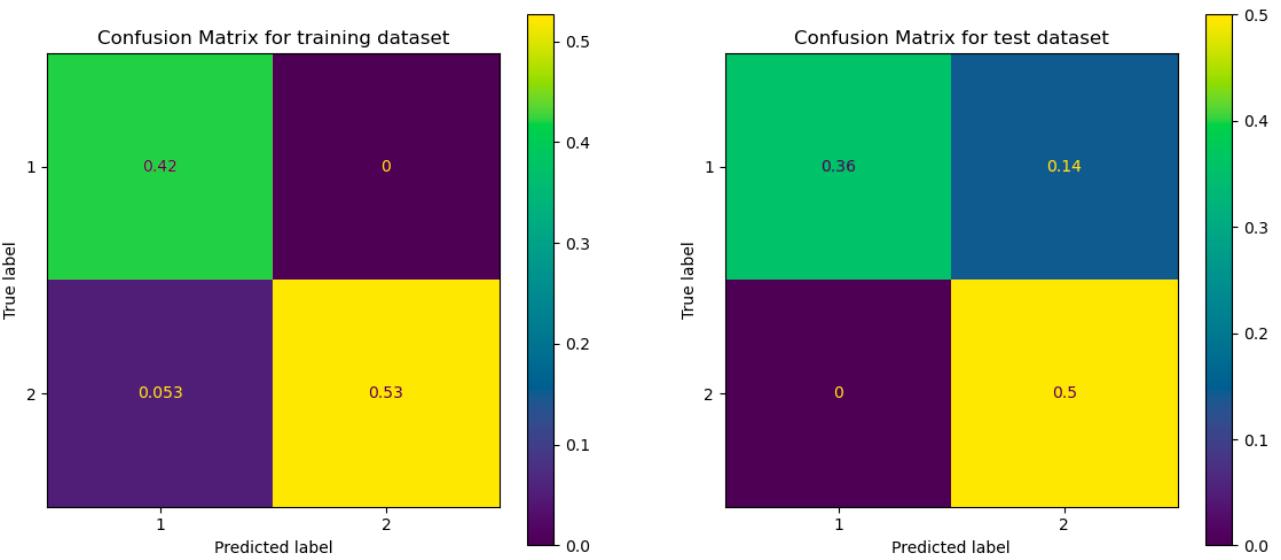
Figure 3. Biplot PC2 vs. PC1 for the peel moiety of the di ff erent apple varieties. (Peelsm1: Peel of Pêro Coimbra Apple, Peelsm2: Peel of Pardo Lindo Apple, Peelsm3: Peel of Repinau Apple, Peelsm4: Peel of Pêro de Borbela Apple, Peelsm5: Peel of Noiva Apple).